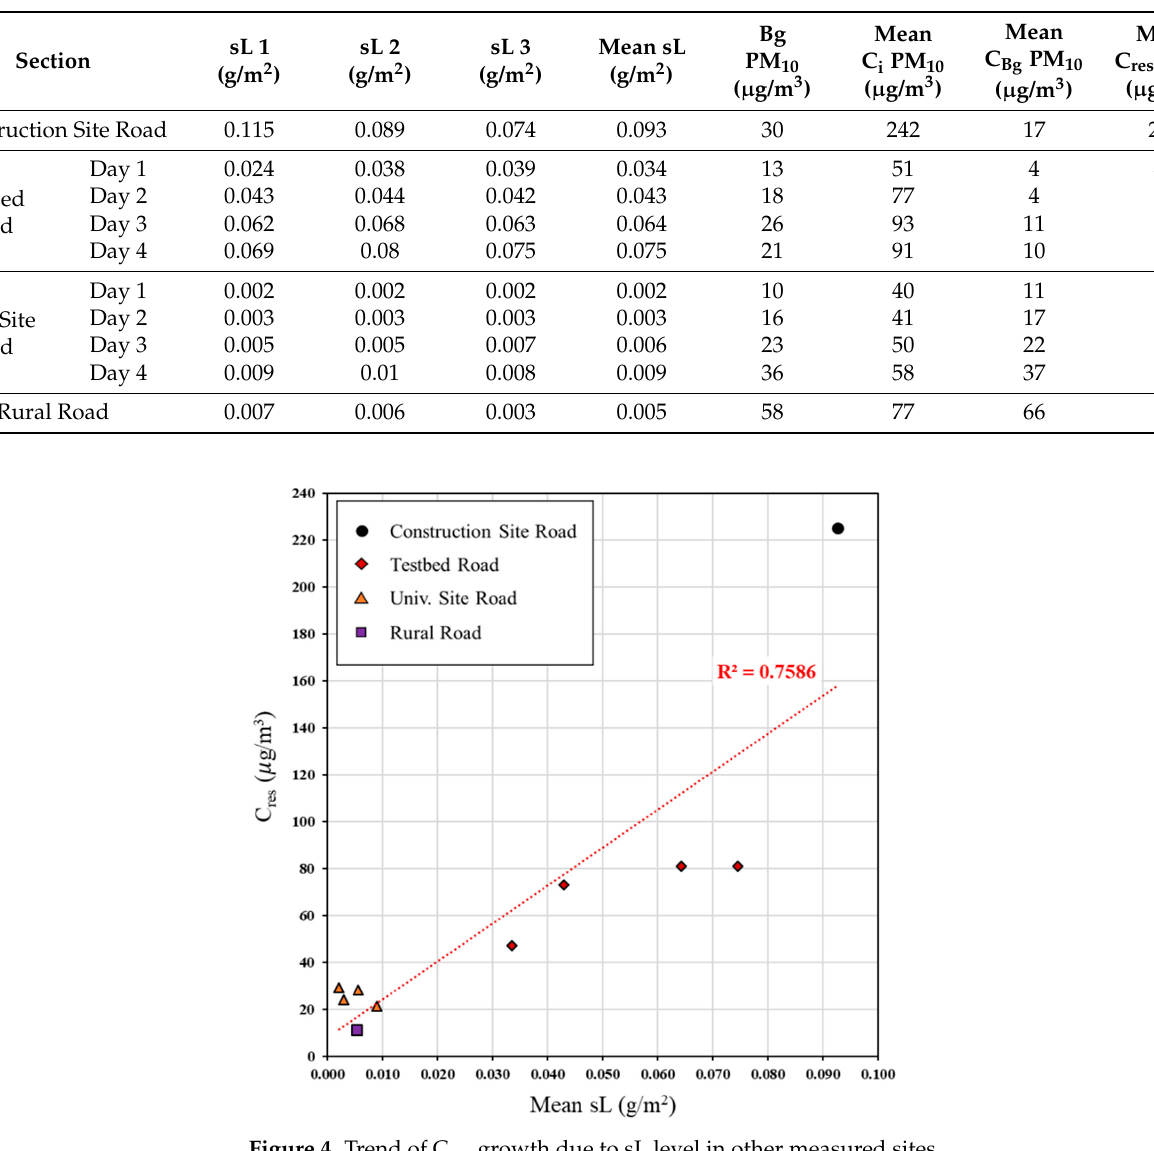
Table 3. Concentration of sL, resuspended PM 10 on paved roads without any traffic.